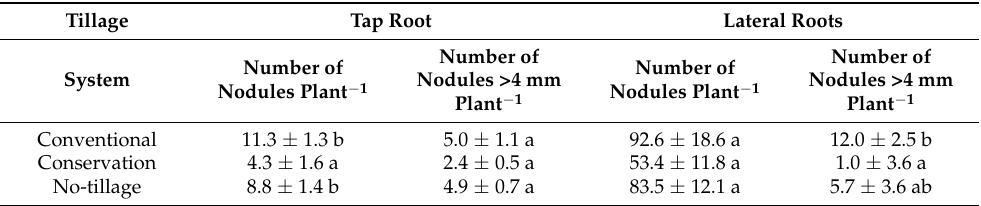
Table 3. Soybean nodule production according to the different tillage systems. Tillage Tap Root Lateral Roots Number of System Nodules Plant − 1